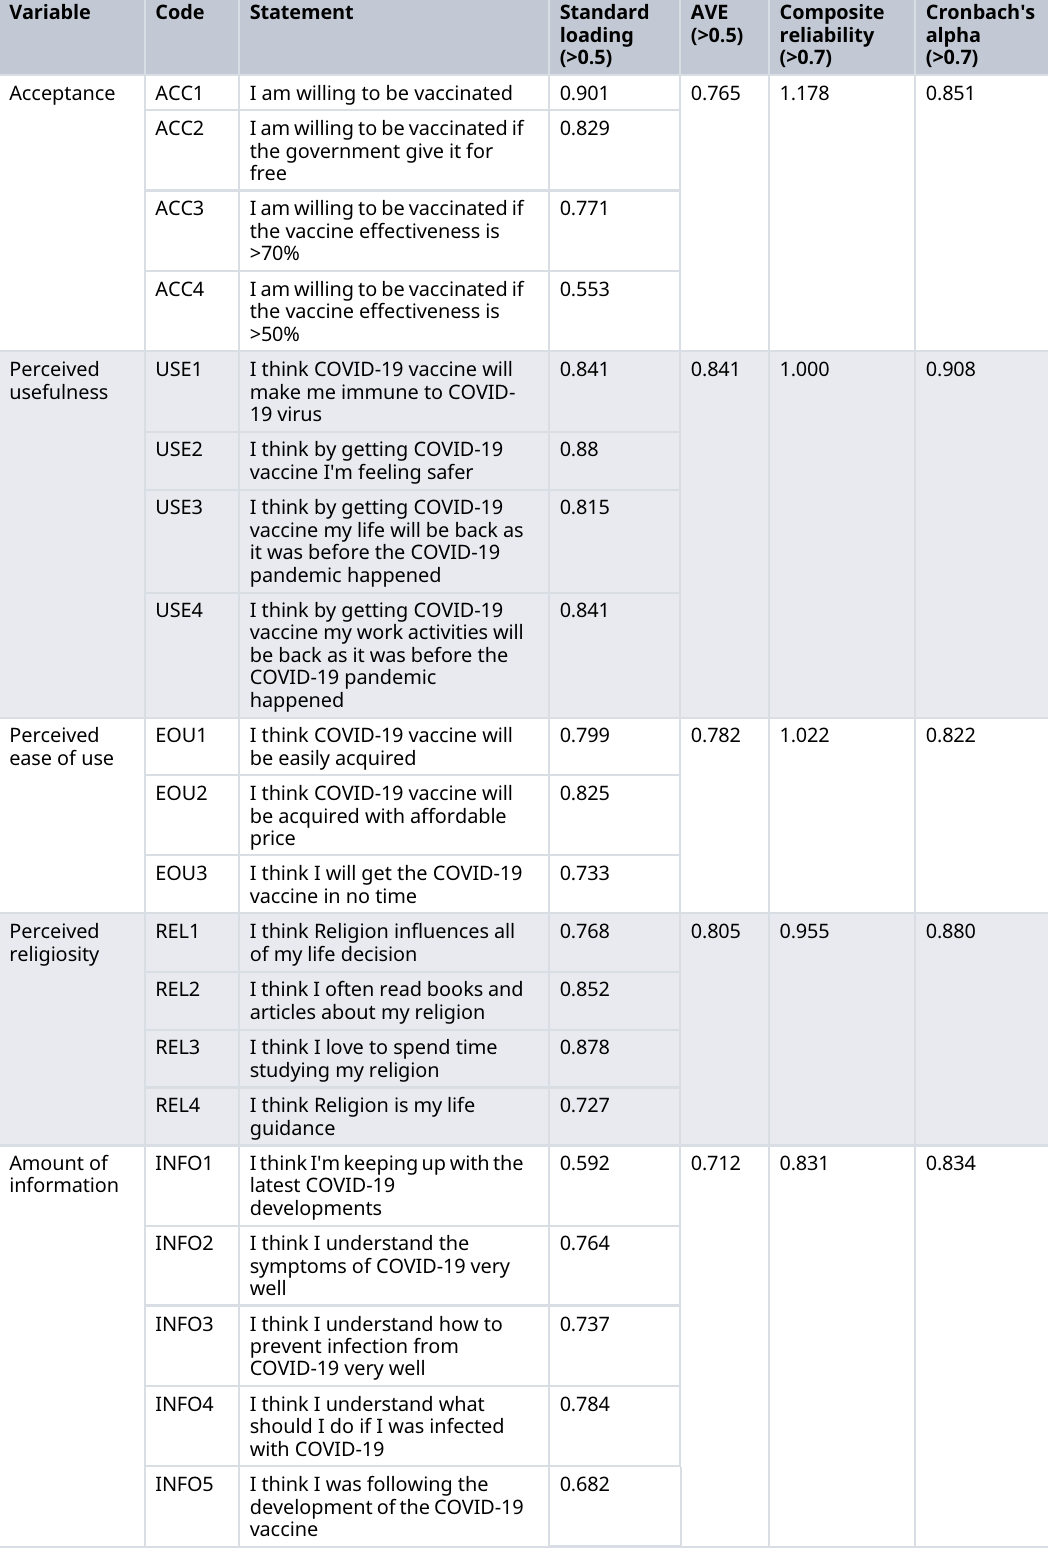
Table 1. Statement or questions used to assess each domain and the validity and reliability test of the questionnaire.